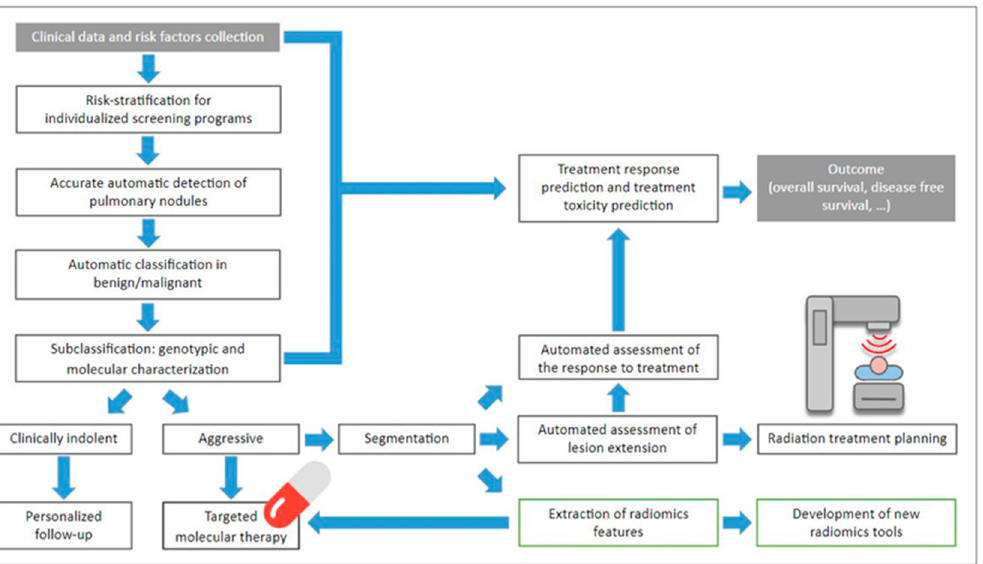
Figure 3. Flowchart showing all the possibilities that AI tools allow for lung cancer, for better and more personalized patient management.